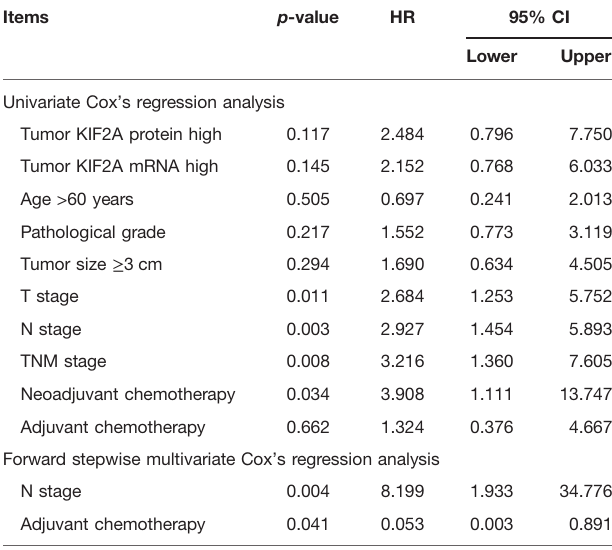
TABLE 4 | Factors affecting OS by Cox ’ s proportional hazards regression analysis.